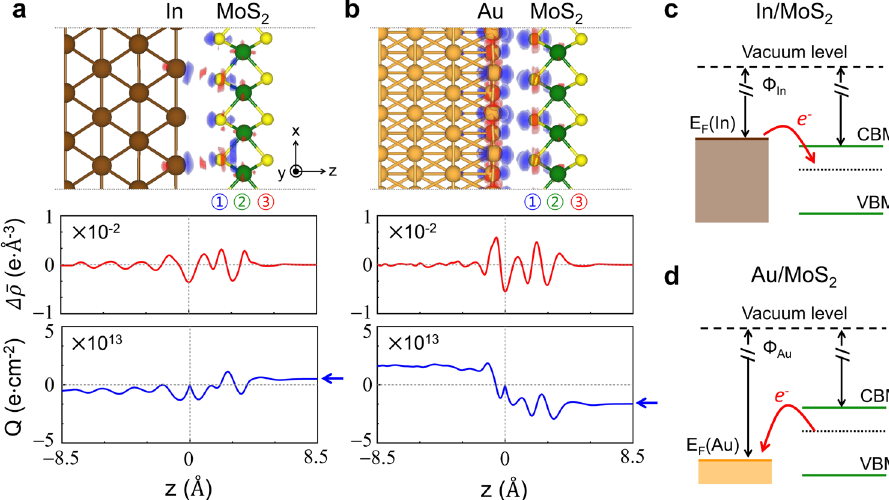
Fig. 3 Charge redistribution properties of the In/MoS 2 interface from DFT calculations. For the a In/MoS 2 and b Au/MoS 2 interface models, (top panels) DFT-optimized atomic geometries, (middle panels) plane-averaged charge density differences Δ ρ , and (bottom panels) total charge transfers Q (bottom) are shown. In the top panels, interfacial charge transfers are overlaid over the atomic structures, with the electron accumulation and depletion regions represented by the red and blue colors, respectively. The isosurface level is 1 × 10 − 3 e Å − 3 . Schematics of the metal and MoS 2 band levels before contact for the c In/MoS 2 and d Au/MoS 2 cases. Dotted lines represent the MoS 2 charge neutrality levels, whose energetic positions with respect to the In and Au Fermi levels E F result in the In-to-MoS 2 and MoS 2 -to-Au interfacial charge transfers.